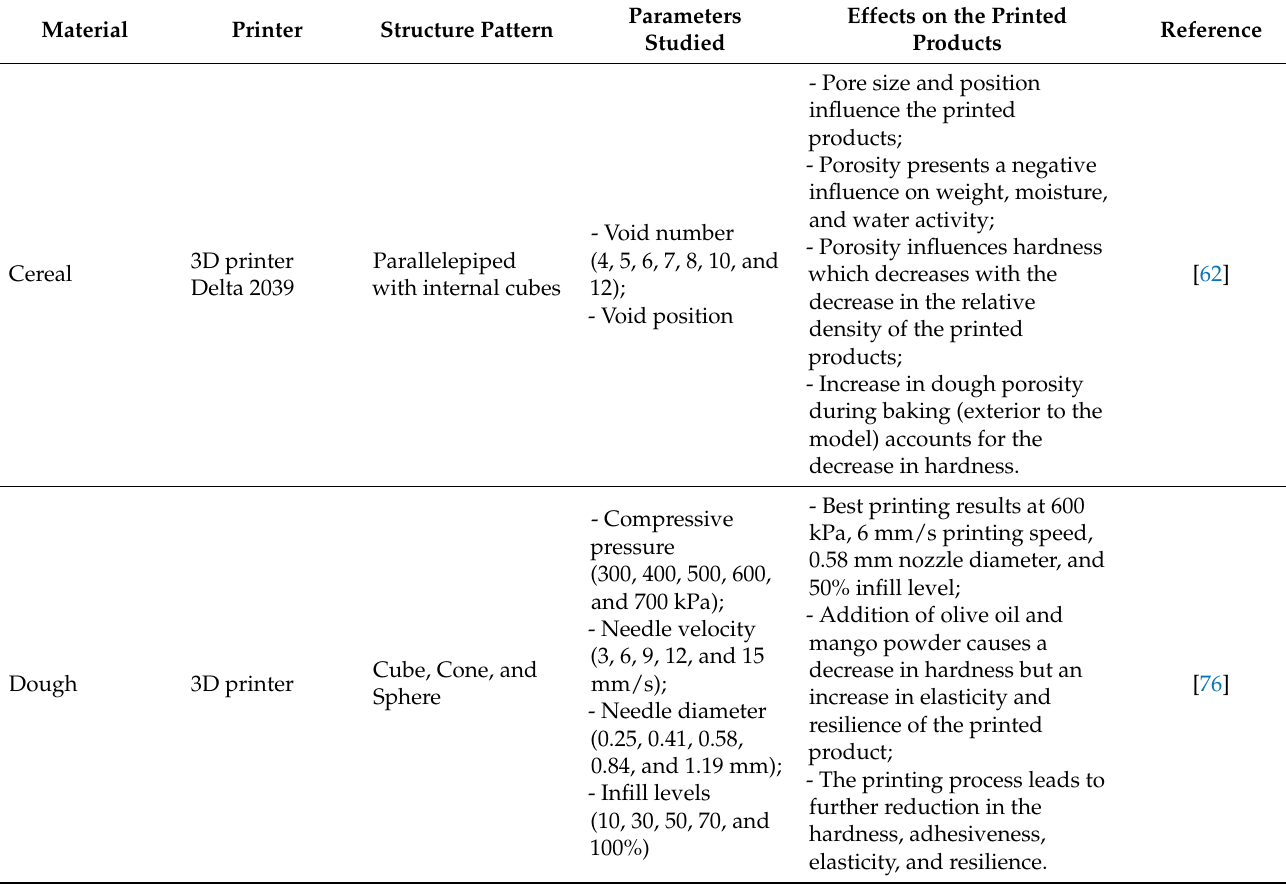
Table 2. Studies correlating the infill parameters with the textural properties of the printed products. Material Structure Pattern